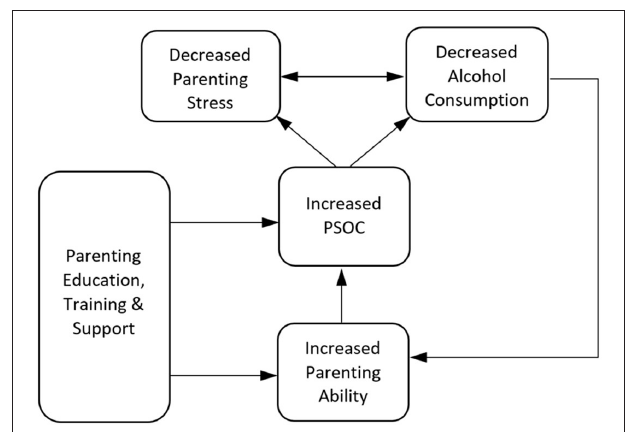
FIGURE 6 | Cycle of parenting sense of competence, parenting stress and alcohol consumption with parenting